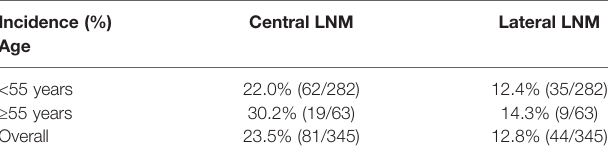
TABLE 5 | The incidence of central and lateral LNM in T1a PTC by age.